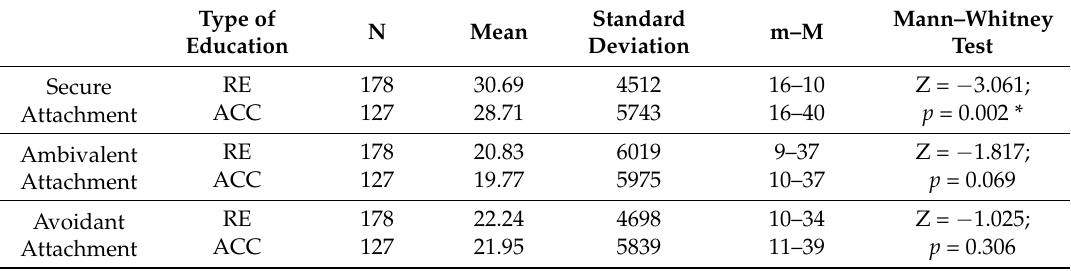
Table 2. Quality of attachment in childhood (IACA); according to the type of education.